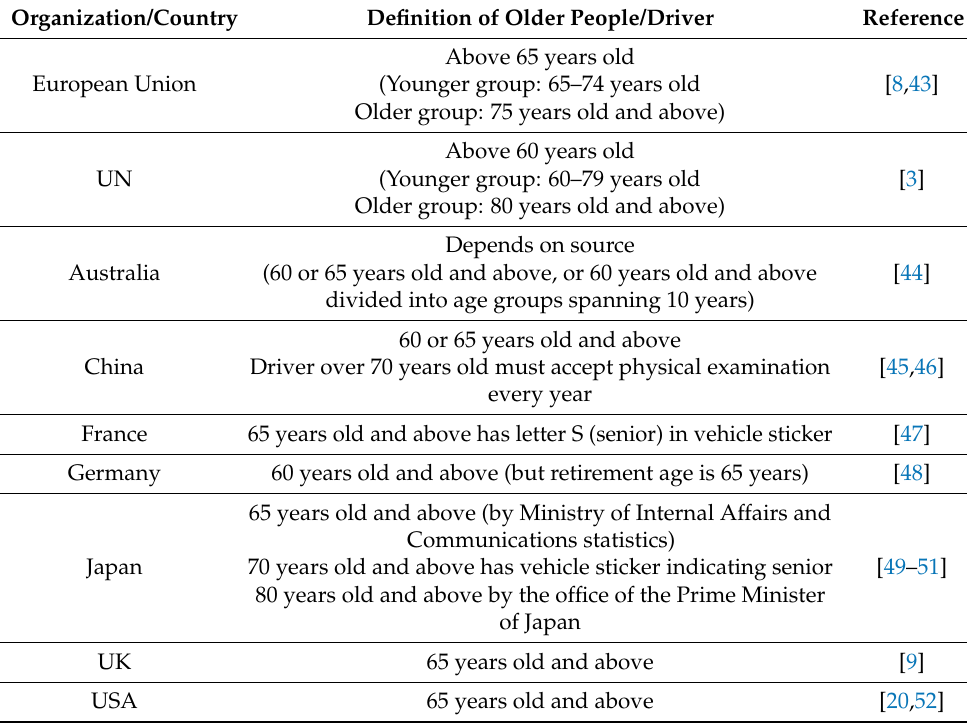
Table 1. Definition of ‘older people/driver’ according to different organizations and countries.